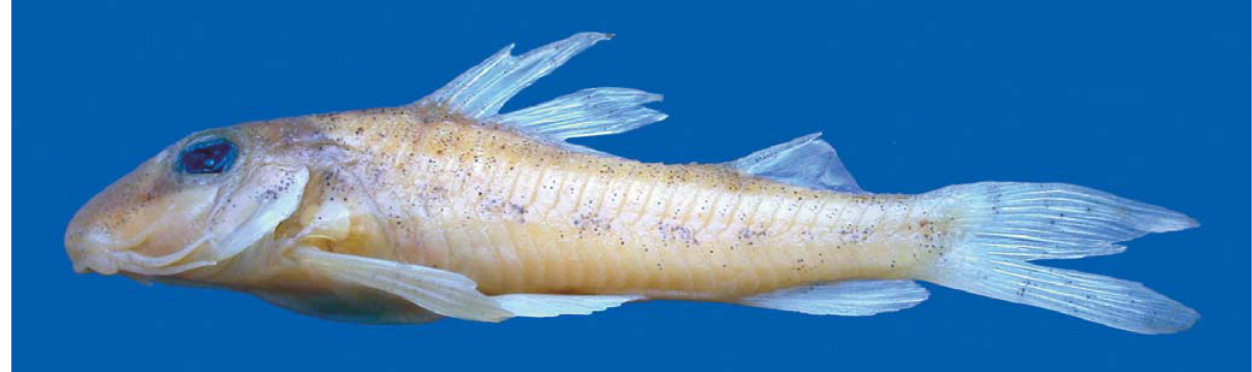
Fig. 1. Aspidoras psammatides , holotype, MNRJ 28407, 25.7 mm SL, Brazil, Estado da Bahia, município de Lençóis, rio Caldeirão.